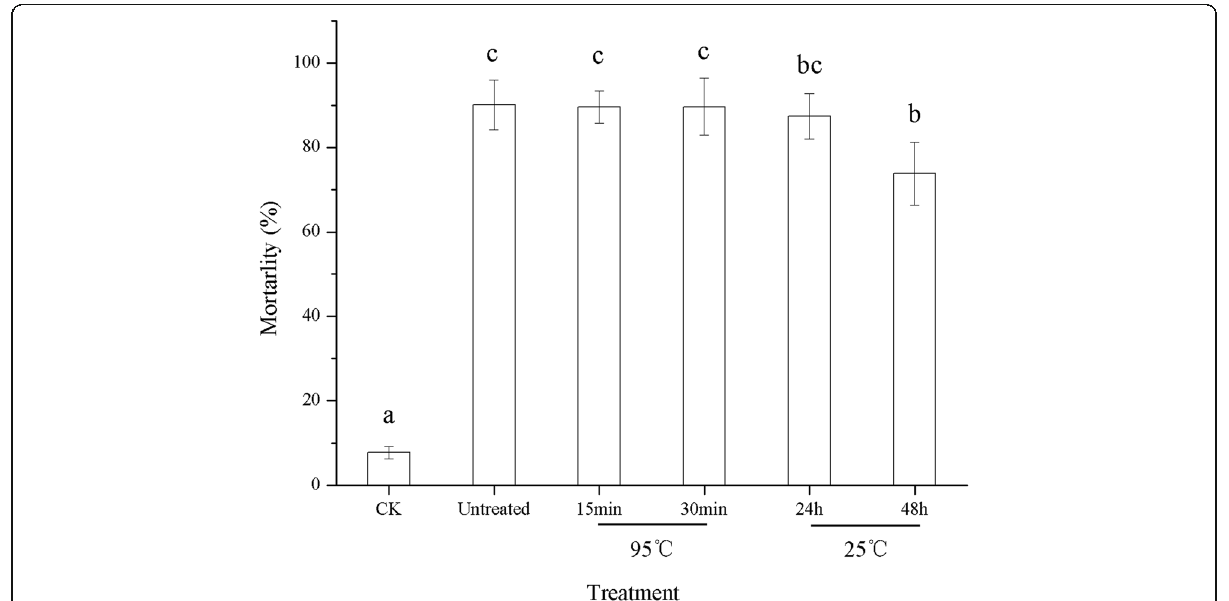
Fig. 2 Mortality of Bemisia tabaci adults fed on AMEP412 subjected to thermal and natural degradation. Means compared using Tukey ’ s HSD test at α = 5%; means superscripted with same letter within a column are not significantly